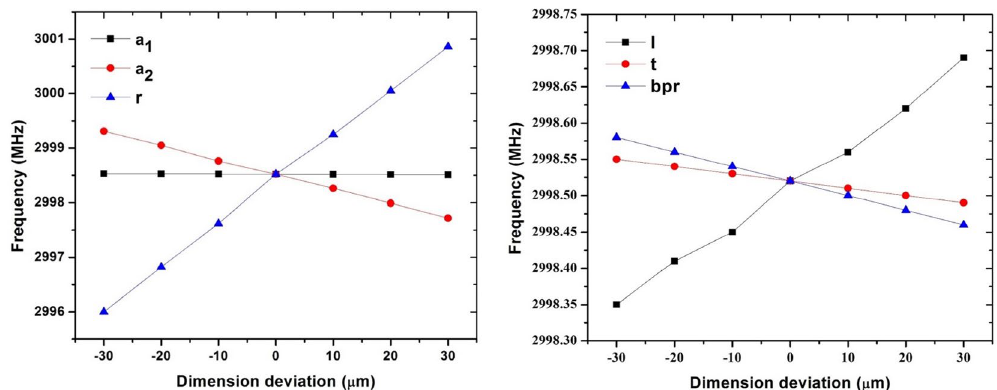
Figure 5. The effect of dimensional tolerance on the resonant frequency.